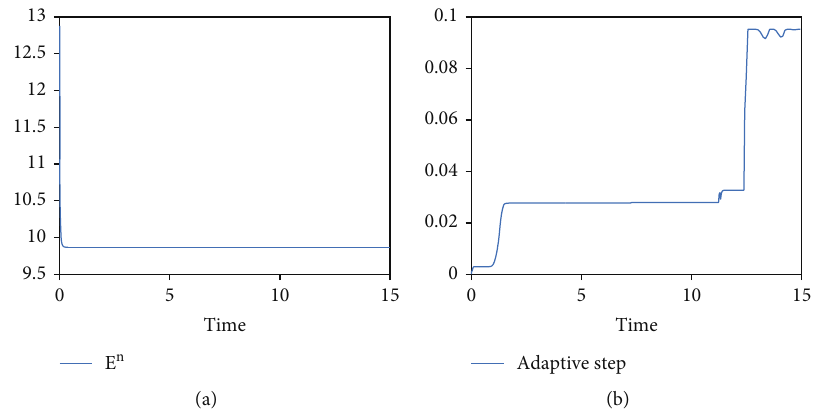
Figure 4: Evolutions of energy (a) and adaptive time steps (b) of the BDF2 scheme (6) for the EFK equation using adaptive time strategy.